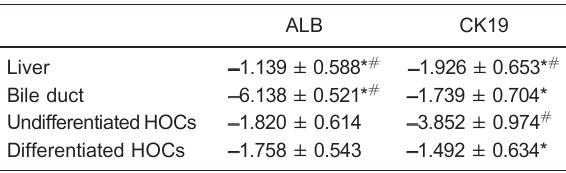
Data are reported as means±SD for 20 independent experi- ments and normalized with b -actin. ALB: albumin; CK19: cytokeratin 19. The negative log was calculated as described in Material and Methods. *P , 0.05 vs undifferentiated hepatic oval